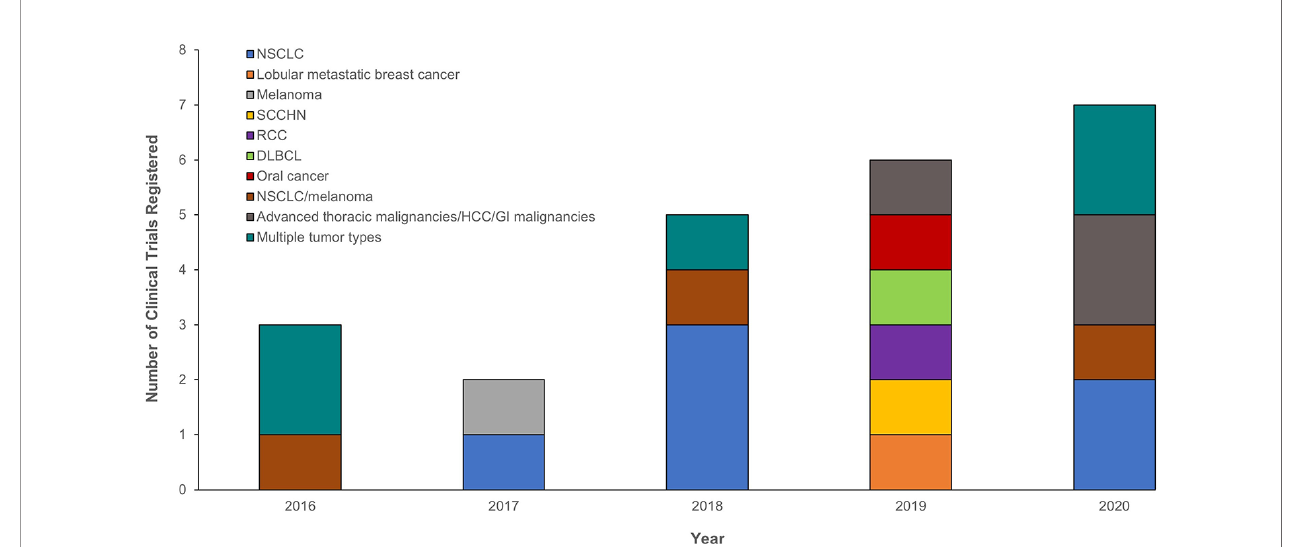
FIGURE 2 | Registered clinical trials between 2016 and 2020 evaluating the potential role of PD-(L)1 PET tracers in assessing PD-(L)1 expression and the tumor types investigated. Only trials registered with ClinicalTrials.gov are presented at the year the trial was initiated. The following search term was used for each year: ( “ nuclear medicine ” OR imaging OR 89Zr OR 18F OR 99mtc) AND (PD-L1 OR PD-1 OR anti-PD-L1 OR anti-PD-1). DLBCL, diffuse large B-cell lymphoma; GI, gastrointestinal; HCC, hepatocellular carcinoma; NSCLC, non-small cell lung cancer; PD-1, programmed death-1; PD-L1, programmed death ligand 1; PET, positron emission tomography; RCC, renal cell carcinoma; SCCHN, squamous cell carcinoma of the head and